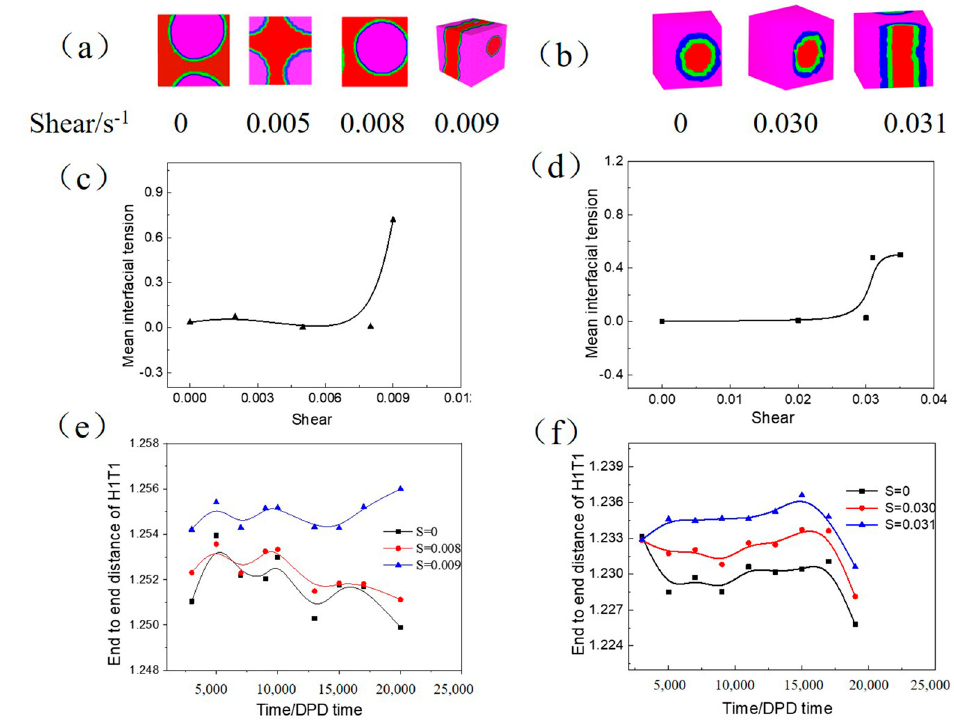
Figure 8. The translucent three-dimensional structure of microemulsion—( a , b ), the corresponding mean interfacial tension—( c , d ) and end to end distance of H1T1—( e , f ) with increasing shear rate. In which, ( a , c , e ) represent O/W microemulsion, ( b , d , f ) represent W/O microemulsion.